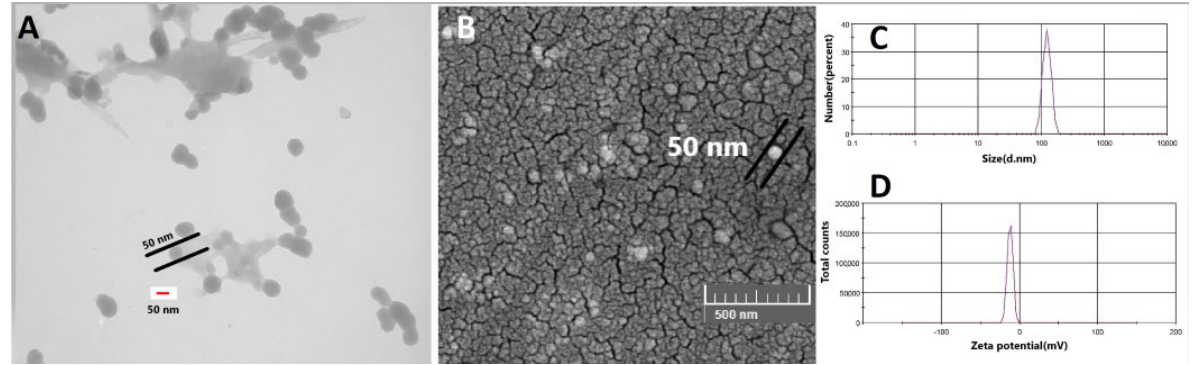
Figure 3. TEM ( A ) and SEM ( B ) photographs of iodine nanoparticles coated with chitosan (INP2). ( C ) Size distribution of iodine nanoparticles, ( D ) Zeta potential distribution of iodine nanoparticles.